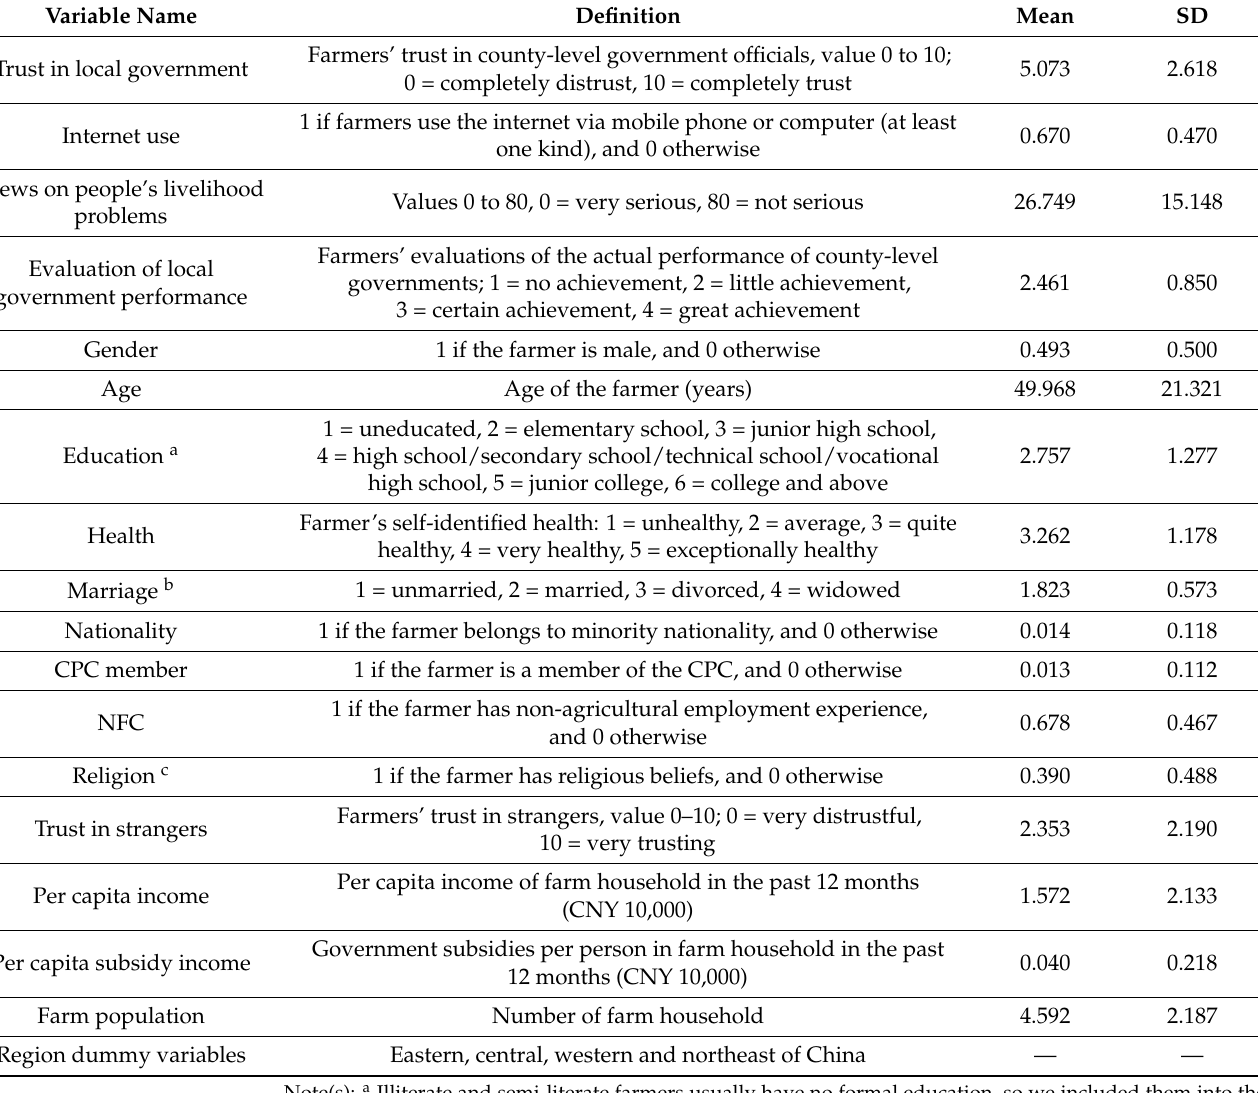
Table 1. Variable definitions and summary statistics of